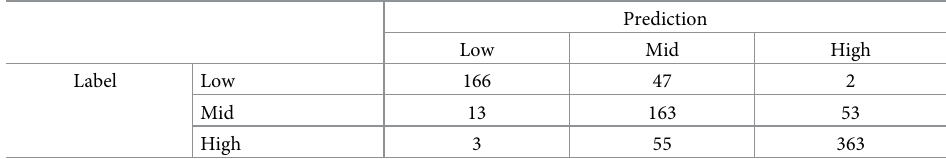
Table 3. Ensemble results.